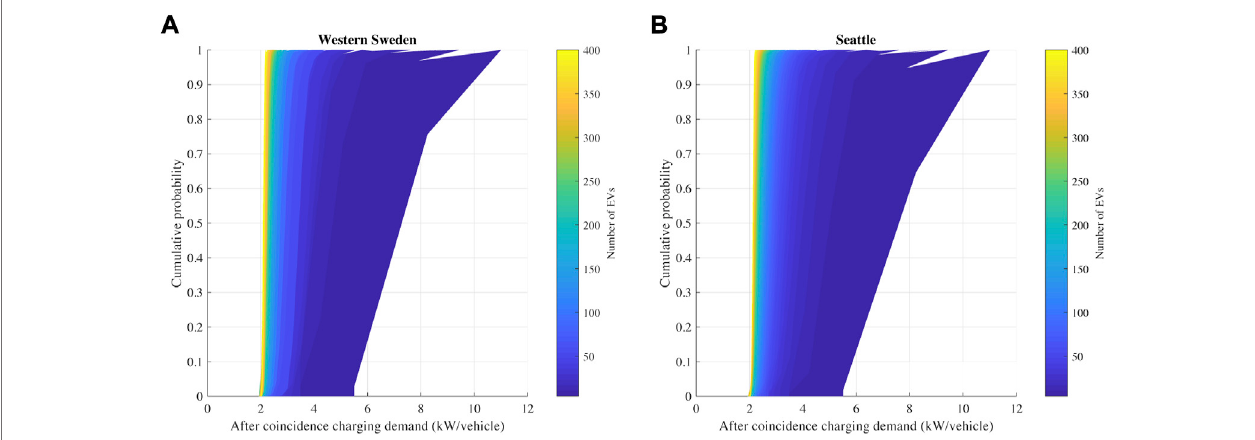
FIGURE 5 | Empirical Cumulative Distribution Function (CDF) of after-coincidence charging power demand based on 132,000 randomized combinations of vehicles. Results for Western Sweden (A) and Seattle (B) . The nominal charging power is 11 kW, the electricity demand per km is assumed to be 0.2 kWh/km and charging location is home